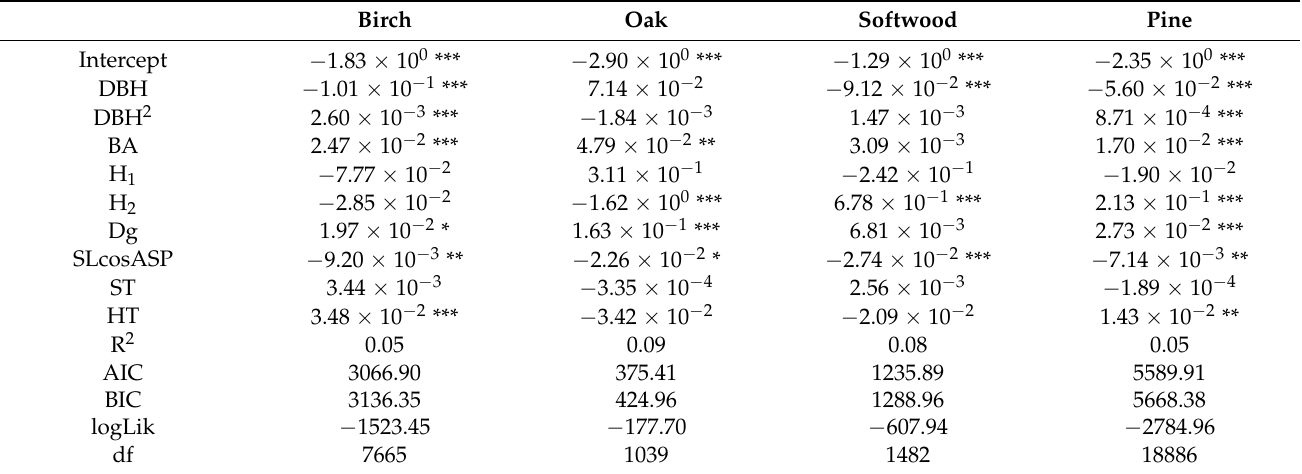
Table A3. The estimated parameters with the lack-of-fit statistics for the mortality equations of the NCM. The dependent variable, mortality, equals one if a tree died between the two inventories, if not, it equals zero. Birch Oak Softwood Pine